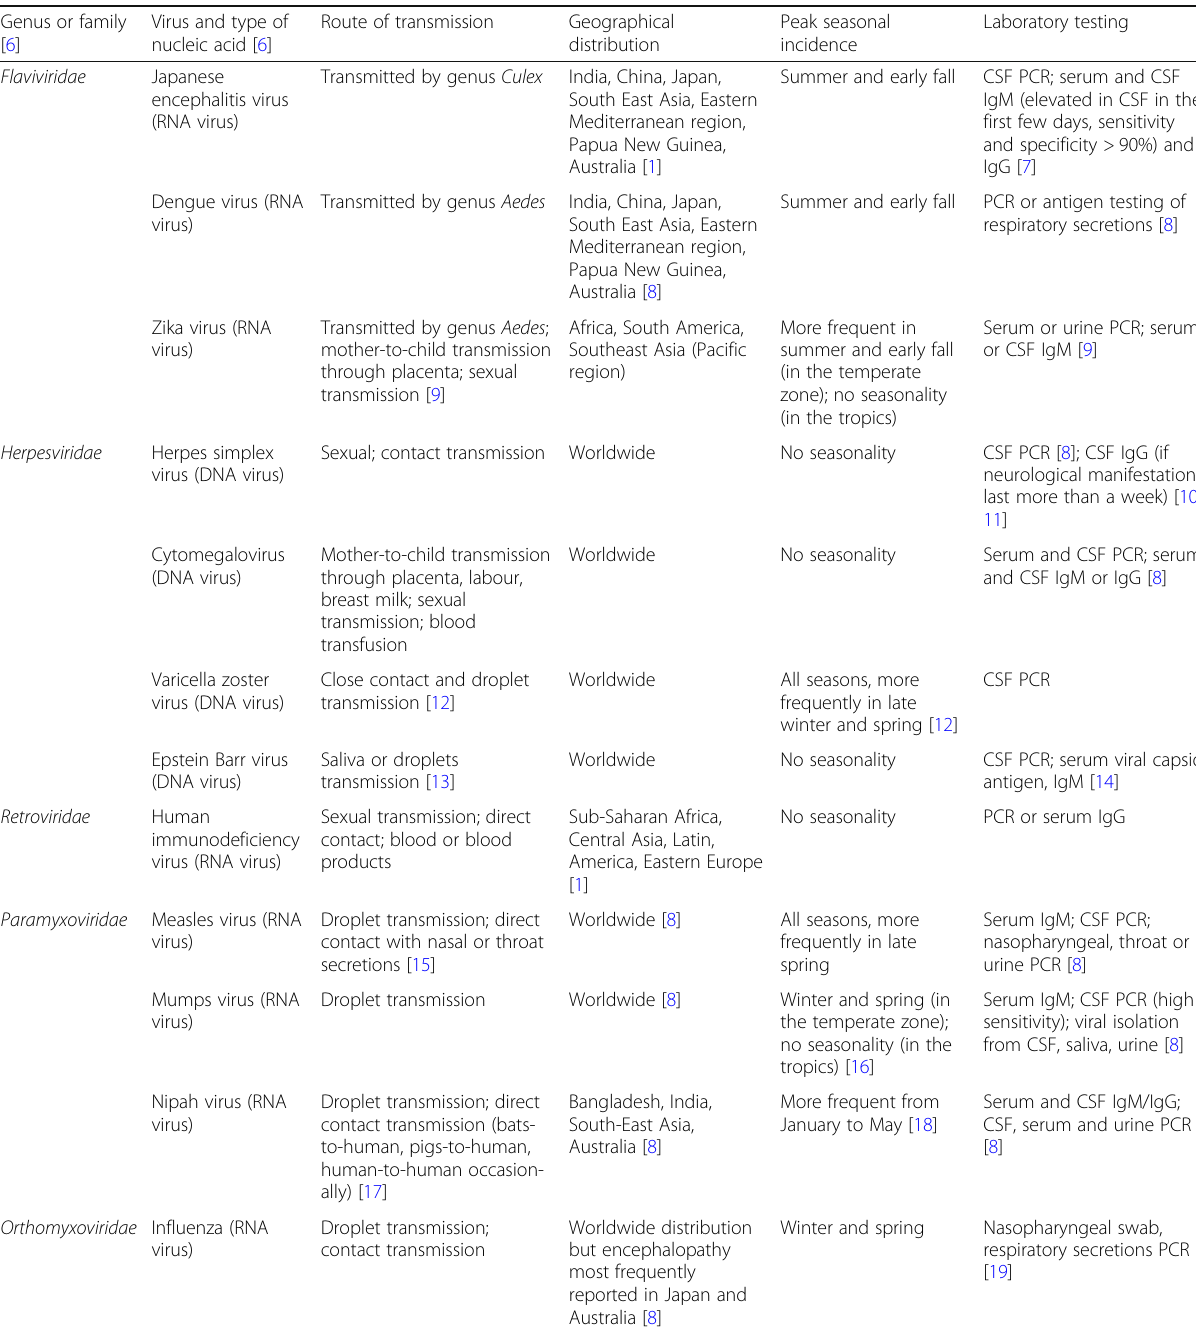
Table 1 Common viruses associated with seizures and epilepsy Genus or family